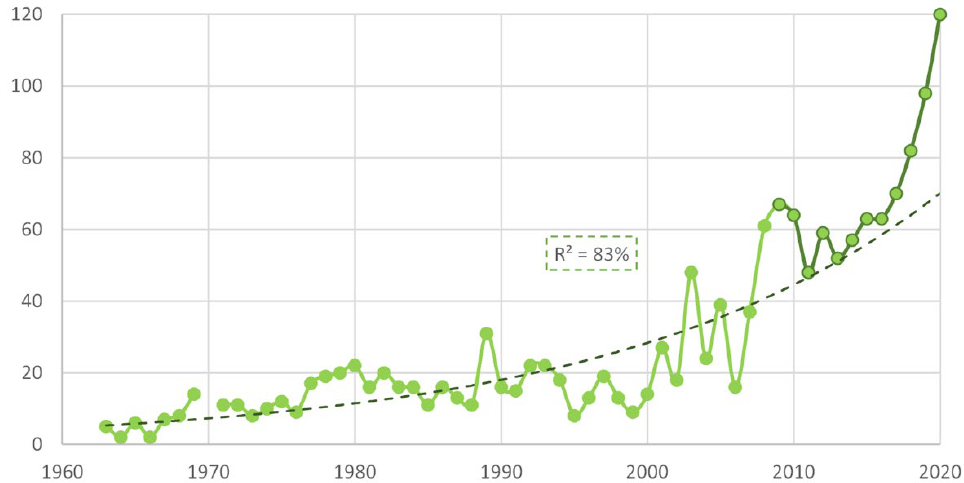
Figure 1. Temporary trend of publications on coffee agronomy (1960s–2020s).